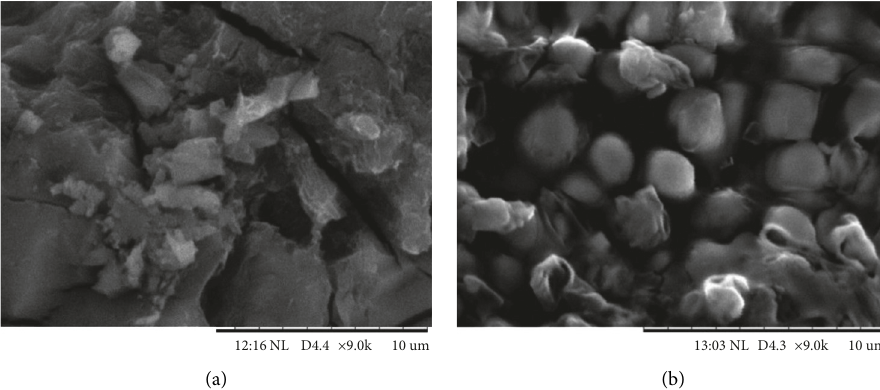
Figure 3: SEM images of the (a) R . tuberosa (L.) extracts ; microcapsules of R . tuberosa (L.) extracts prepared in pH 4, 0.1% (w/v) chitosan and 90min stirring time. The magnification was